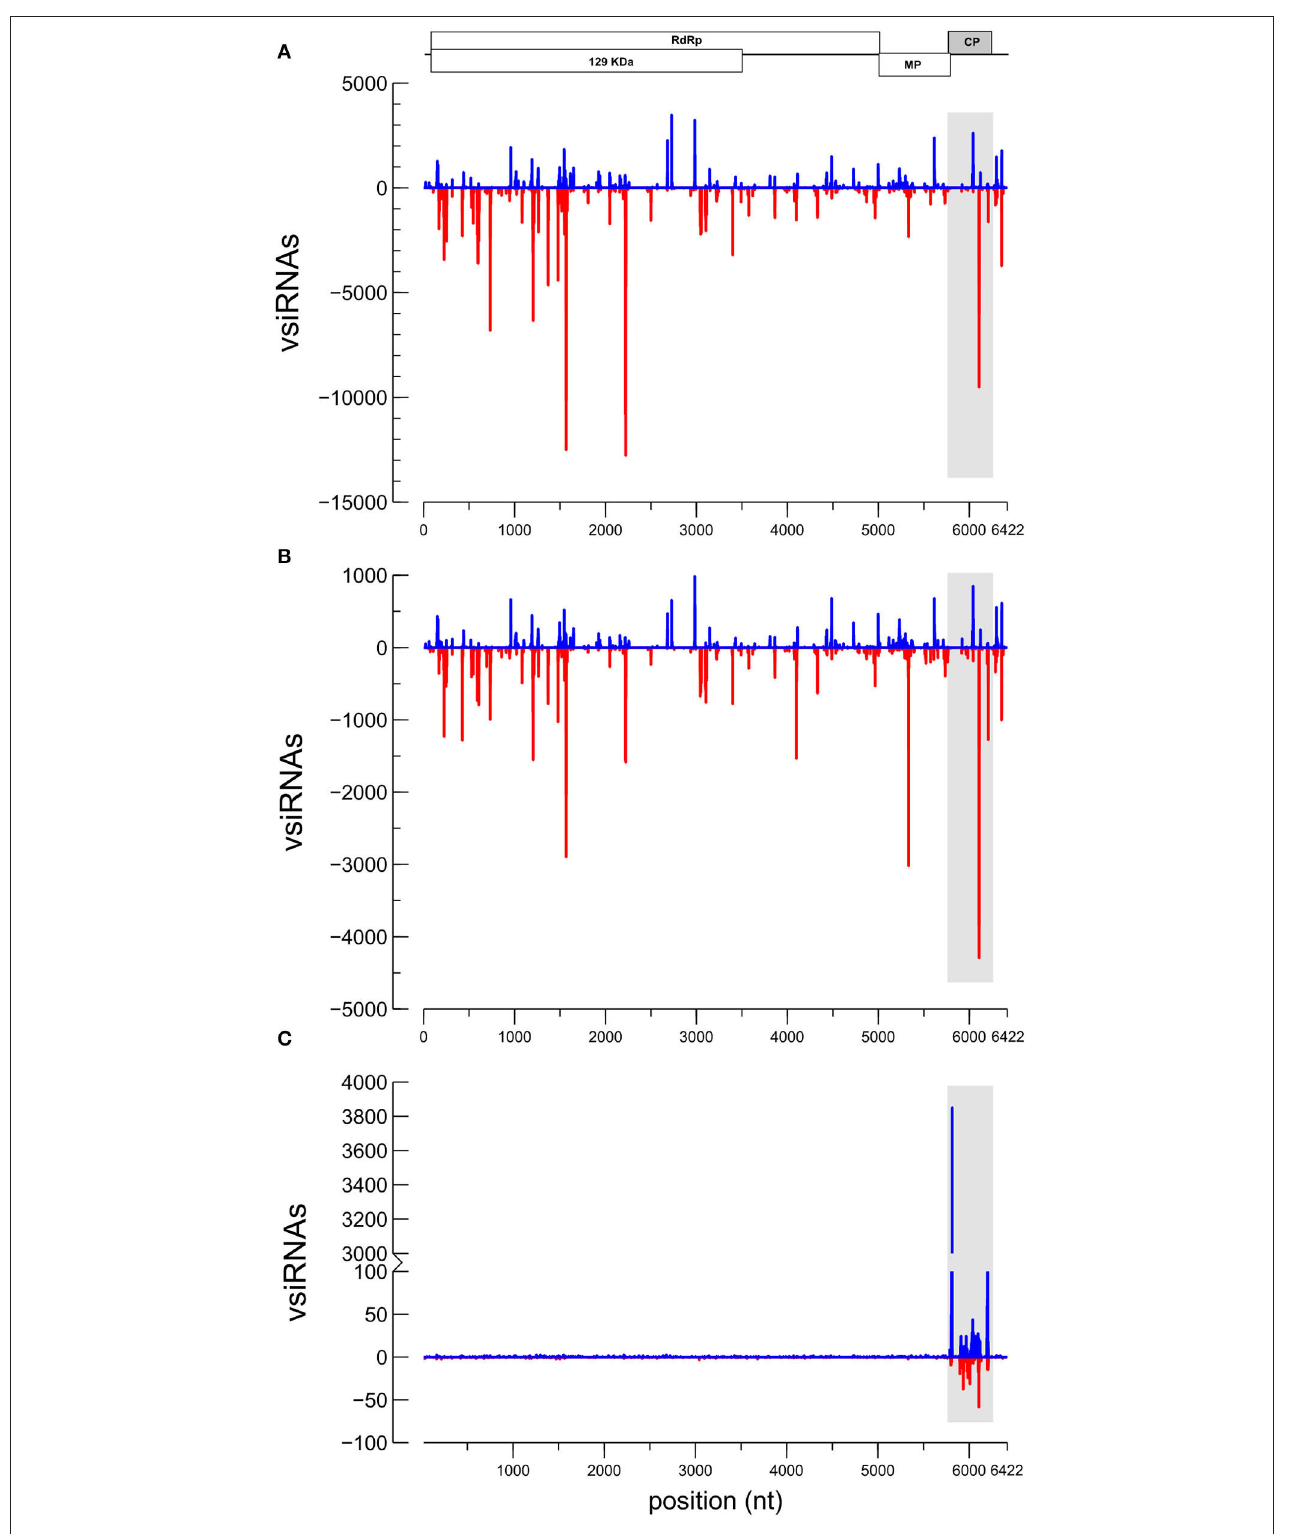
FIGURE 4 | Profile distributions of the small RNAs of the 21–24 nt classes aligning to the genome of CGMMV: (A) Sample MO [CGMMV]; (B) sample DS [dsRNA + CGMMV]; and (C) sample NI [dsRNA]. Peaks above and below the x-axis stand for sense and antisense virus-derived small interfering RNAs (vsiRNA) orientations, respectively. A schematic view of the CGMMV genome is represented above for reference. The separation between marks in the x -axis represents 1Kb. The shadowed area indicates the target for the sprayed dsRNA in the genome.